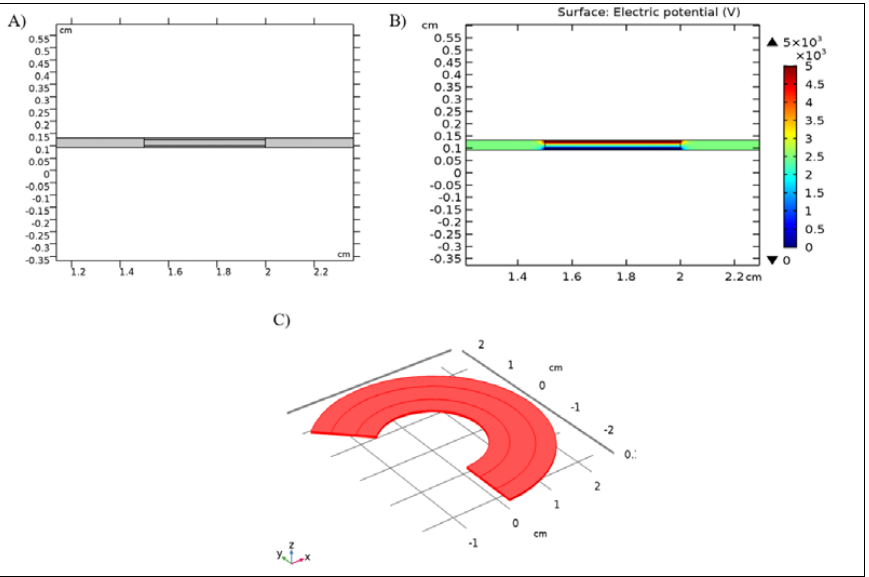
Figure 2. ( A ) Cross-Section of Modeled Actuator ( B ) Applied Electric Potential at Electrode Surfaces (Sample 4000 V) ( C ) 2-D Axisymmetric Revolution.